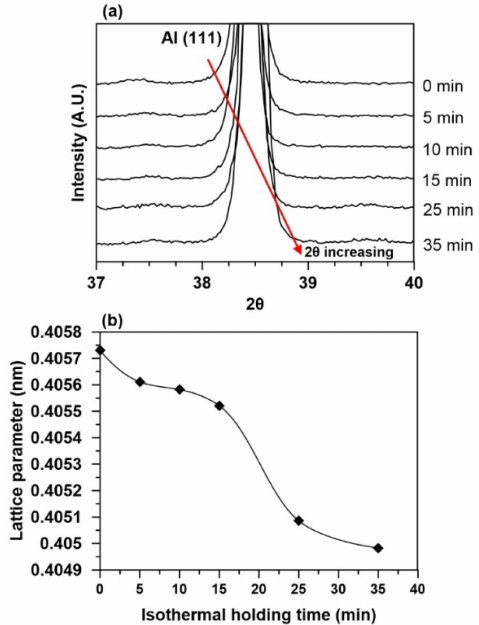
Figure 10. ( a ) XRD peaks corresponding to the Al(111) plane in XRD patterns of Figure 5; ( b ) lattice parameter variations of aluminum in 20% compressed samples heated at 600 ˝ C for different